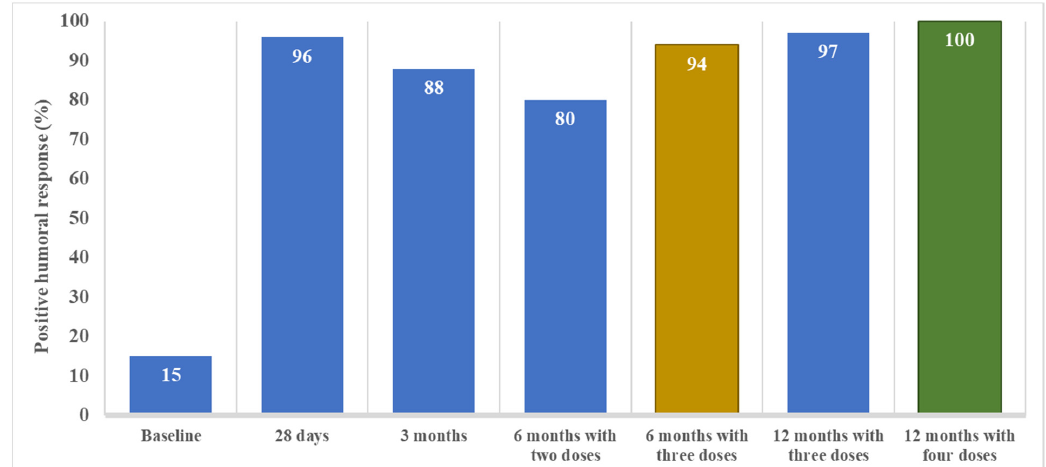
Figure 1. The positive humoral response over time from baseline (prior to SARS-CoV-2 vaccination) to 12 months after completing the initial vaccine schedule (i.e., 2 doses of mRNA vaccine) in CKD patients on peritoneal dialysis. A positive humoral response was defined as anti-spike antibody titers above 36 UI/mL. Note that samples obtained at 6 and at 12 months following the initial vaccine schedule of two doses of mRNA-based vaccines are divided into patients that had received 2 (just the initial schedule) or 3 doses (initial schedule plus one booster dose) at the 6-month timepoint or 3 or 4 doses (12-month timepoint).